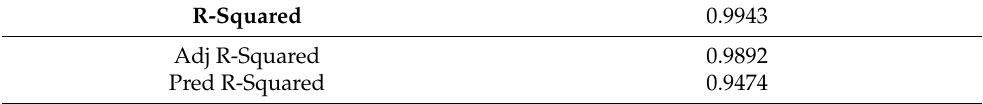
Table 6. Determination parameters used to assess and validate the model for DPPH